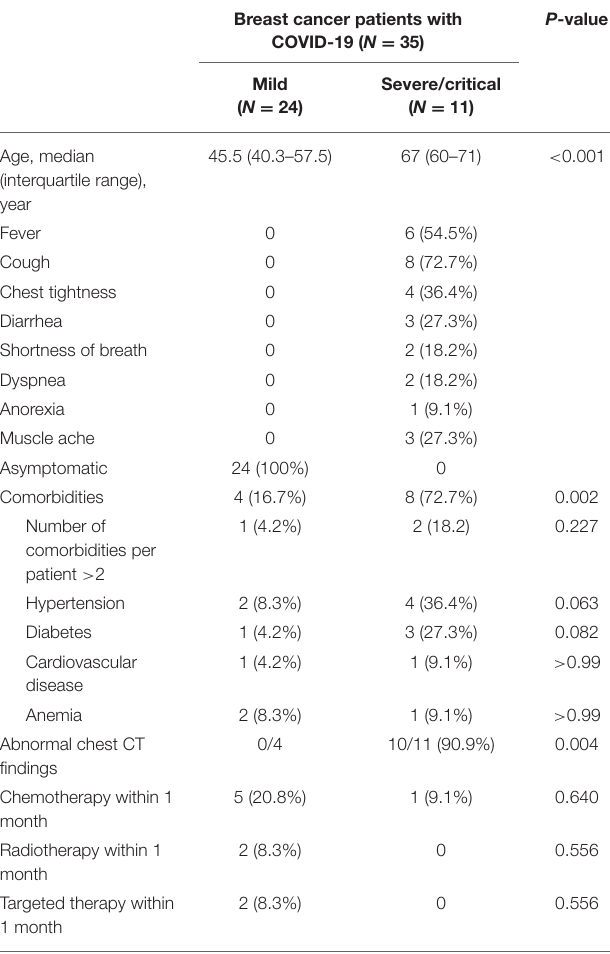
TABLE 7 | Univariate analysis of the correlation between clinical factors and severity of disease in breast cancer patients with COVID-19. Breast cancer patients with COVID-19 ( N = 35)